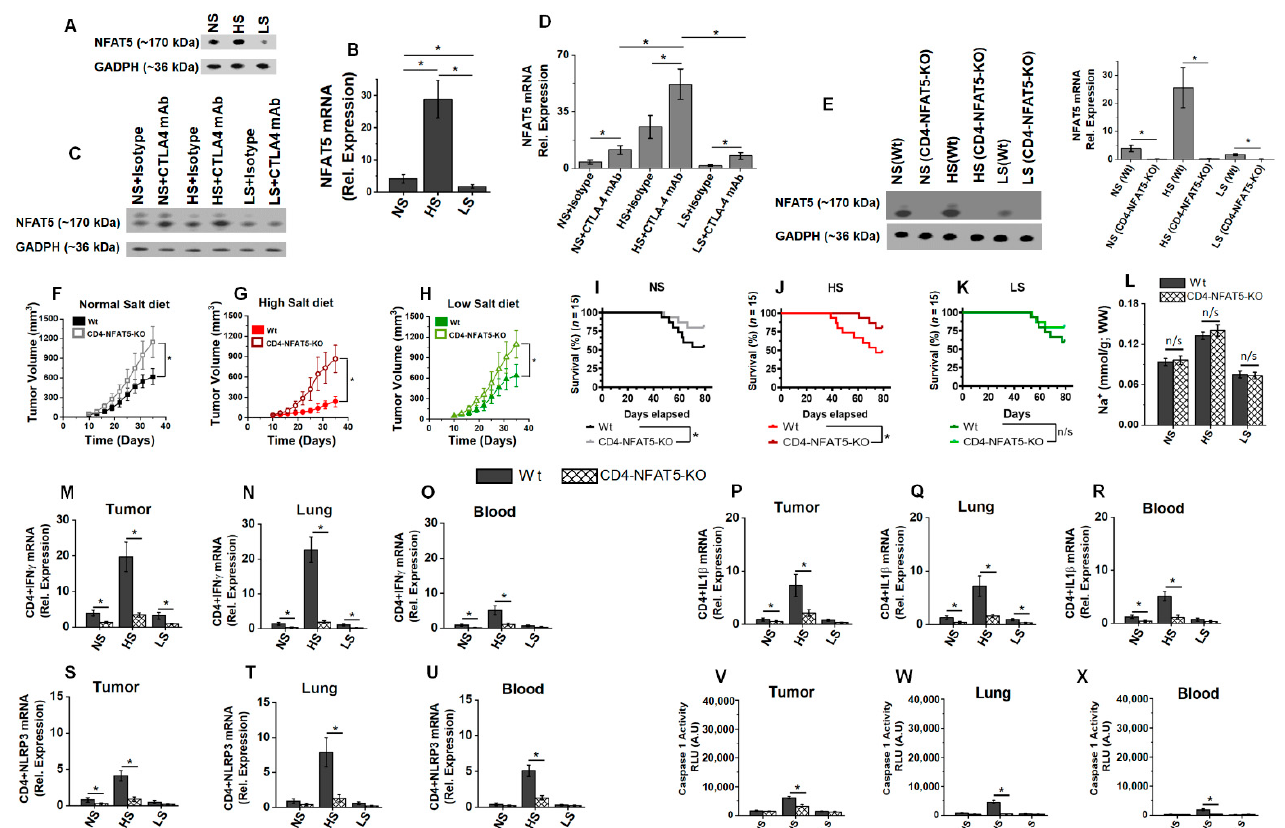
Figure 6. NFAT5 is the upstream modulator of inflammasome activation in high-salt-mediated irAE response. ( A ) Western-blot-based protein analysis for NFAT5 expression in CD4+T cells isolated from tumor-infiltrating immune cells in NS, HS and LS diet cohorts. ( B ) qRT-PCR-based NFAT5 mRNA expression in CD4+T cells isolated from tumor-infiltrating immune cells in NS, HS and LS diet cohorts. ( C , D ) Western-blot- ( C ) and qRT-PCR- ( D ) based analysis of NFAT5 expression in CD4+T cells isolated from tumor-infiltrating immune cells in NS, HS and LS diet cohorts following treatment with anti-CTLA4 mAb or isotype control. ( E ) Transgenic murine model with CD4 specific NFAT5 knock out (CD4-NFAT5-KO) in C57Bl/6 background were utilized for further breast tumor studies. Western blot analysis confirmed the lack of NFAT5 expression in our CD4-NFAT5-KO model. ( F – H ) Tumor progression kinetics in NS ( F ), HS ( G ) and LS ( H ) cohorts in wild-type (Wt) and CD4-NFAT5-KO transgenic mice injected with syngeneic Py230. Data presented as mean ± SEM, n = 8 (biological replicates); statistical analysis was performed using multiple t -test, (*) p -value < 0.05; n/s = not significant. ( I – K ) Survival rate in the three salt-modified diet cohorts—NS ( I ), HS ( J ) and LS ( K )—in breast-tumor-bearing Wt and CD4-NFAT5-KO mice followed for 80 days. The n =15 per cohort, statistical analysis performed by log-rank Mantel–Cox comparison. ( L ) CD4-specific knock out of NFAT5 did not change the tumor [Na + ] accumulation. ( M – O ) The mRNA expression of IFN γ in CD4+T cells isolated from tumor ( M ), lung ( N ) and blood ( O ) of Wt and CD4-NFAT5-KO in NS, HS and LS diet cohorts. ( P – R ) The mRNA expression of IL1 β in CD4+T cells isolated from tumor ( P ), lung ( Q ) and blood ( R ) of Wt and CD4-NFAT5-KO in NS, HS and LS diet cohorts. ( S – U ) The mRNA expression of NLRP3 in CD4+T cells isolated from tumor ( S ), lung ( T ) and blood ( U ) of Wt and CD4-NFAT5-KO in NS, HS and LS diet cohorts. ( V – X ) Caspase-1 activity CD4+T cells in tumor ( V ), lung ( W ) and blood ( X ) from Wt and CD4-NFAT5-KO in NS, HS and LS diet cohorts. Data analyzed by one-way ANOVA for multiple comparisons; data presented as mean ± SEM, n = 8 (biological replicates) per cohort, (*) p -value <